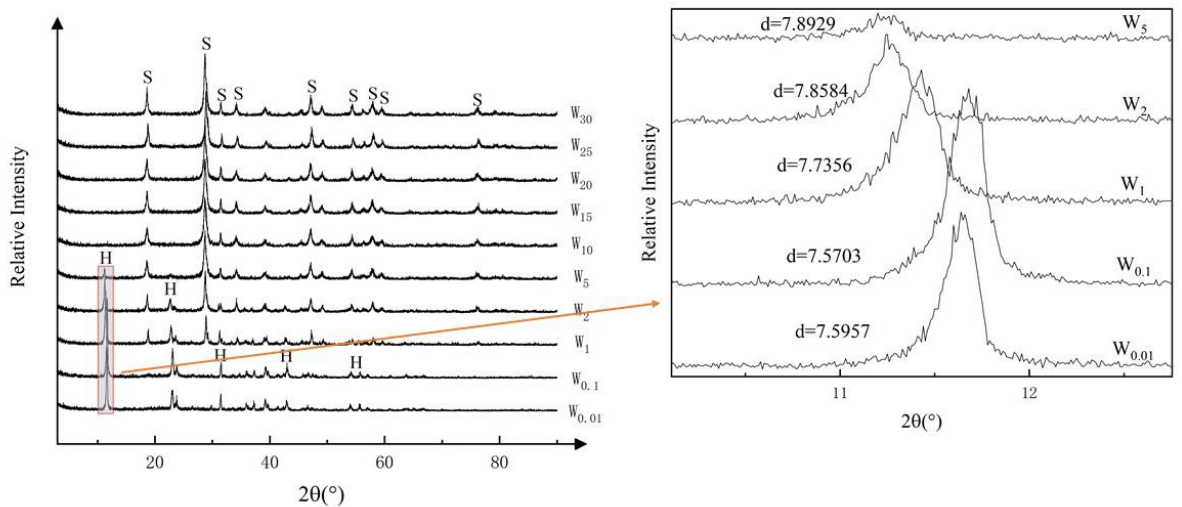
Figure 3. XRD patterns of hydrocalumite after reaction with tungsten. H: hydrocalumite; S: scheel- ite. The sample numbers beside the curves indicate the initial tungsten concentration in solution (in mmol/L).